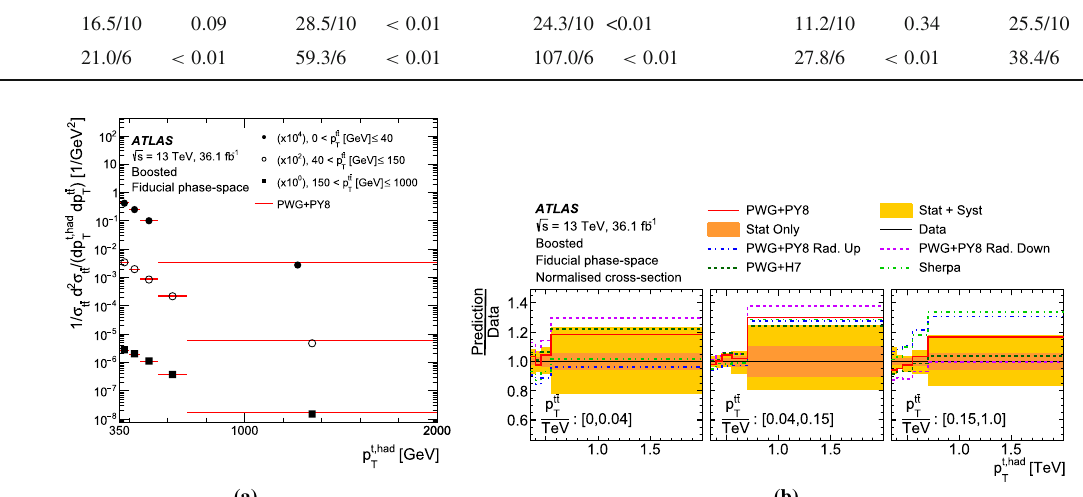
Fig. 43 a Particle-levelnormaliseddifferentialcross-sectionasafunc- tion of p t , had in bins of p t ¯ t in the boosted topology compared with the T T prediction obtained with the Powheg + Pythia8 MC generator. Data